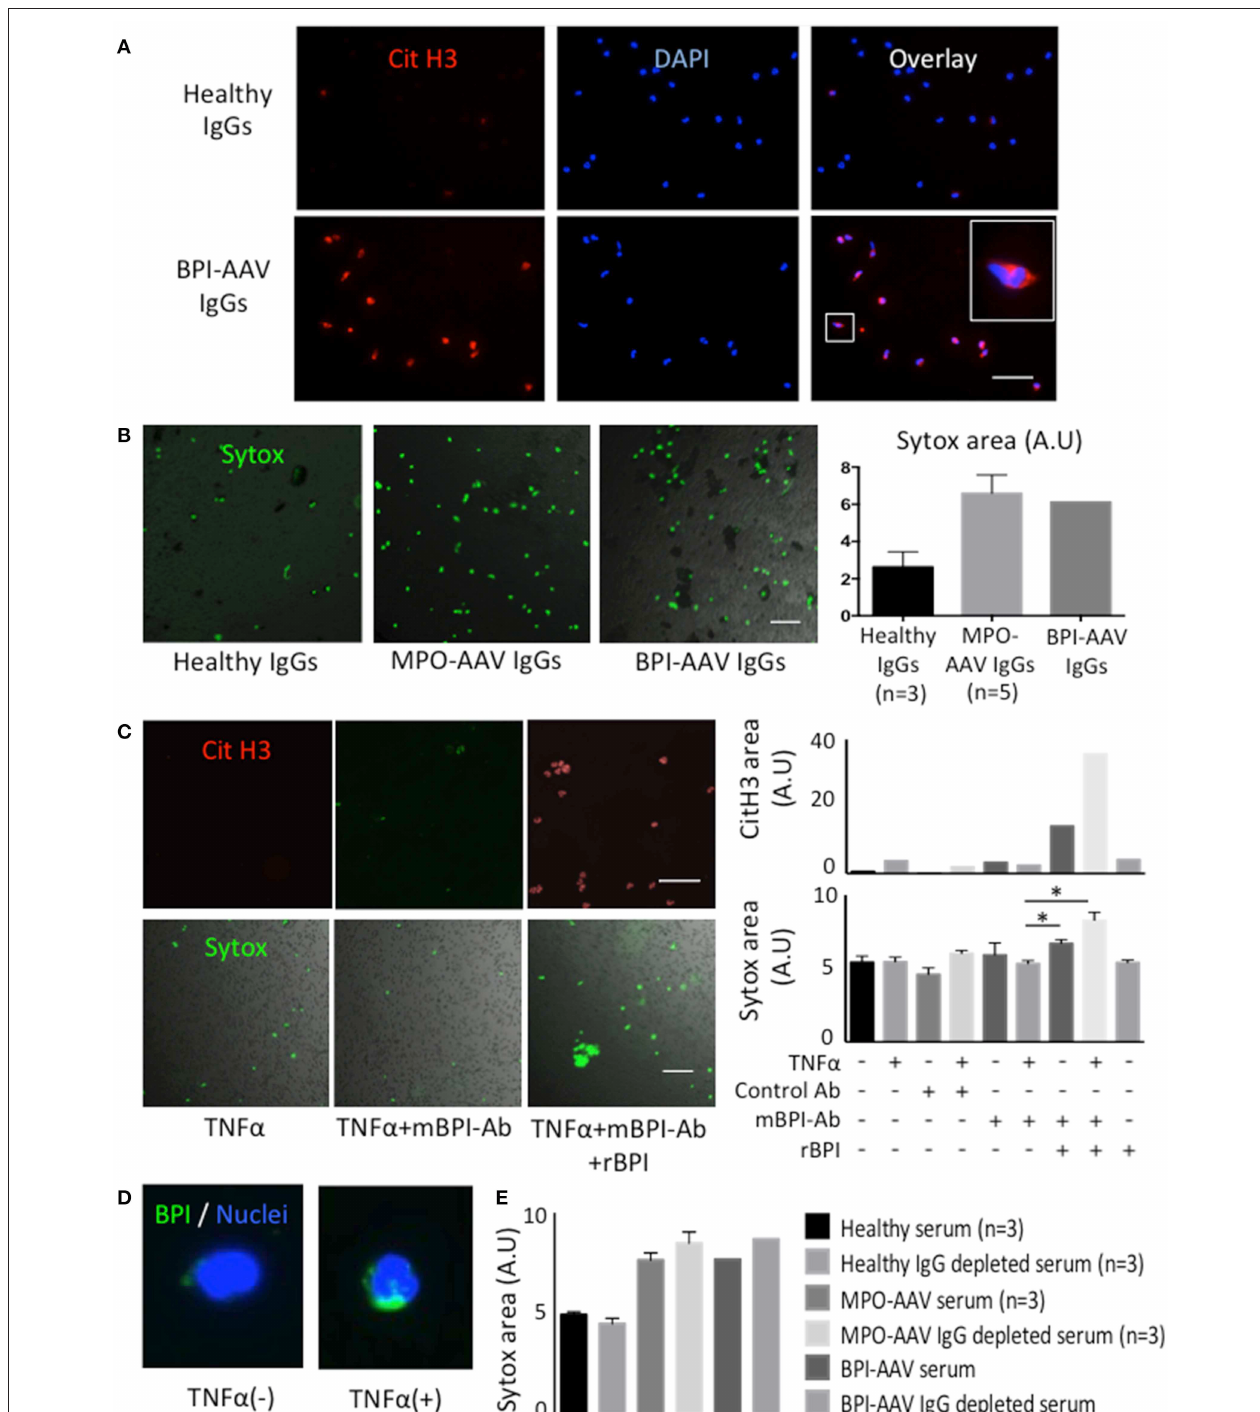
FIGURE 2 | BPI-ANCAs induce NETs with hyper citrullinated histones. (A) Representative NETs staining of healthy or BPI-AAV patient IgGs-stimulated neutrophils using CitH3 (red) and DAPI (BLUE). (B) Representative Sytox-positive neutrophils live image. From the left, healthy IgGs ( n = 3), MPO-AAV patient IgGs ( n = 5), BPI-AAV patient IgGs. Right figure shows Sytox-positive areas quantified by Image J. (C) Representative CitH3-positive NETs and Sytox-positive neutrophils treated with TNF α , TNF α + mBPI-Ab, TNF α + mBPI-Ab + rBPI. Right figures show CitH3-positive area (upper) and Sytox-positive area (lower) under each situation. Data represent the mean ± SEM of three independent experiments and were analyzed using unpaired t -test (PRISM software, GraphPad). * p < 0.05. (D) BPI expression